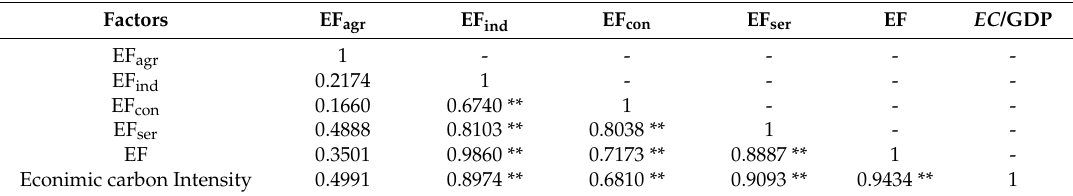
Figure 2. The Cumulative Contributions of Various Sectors’ Energy Efficiency to Economic Carbon Intensity Change. Table 4. Pearson Correlation Coefficient among Energy Efficiency Contributions in Each